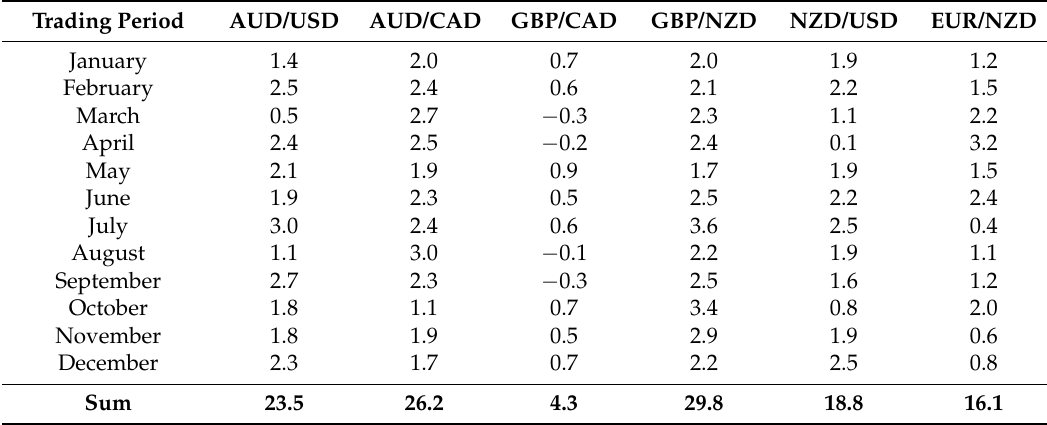
Table 8. Summary of the monthly RR (%) obtained by trading with IDBA to each of the six considered currency pairs. The trading period is from 1 January 2017 to 31 December 2017. Trading Period AUD/USD